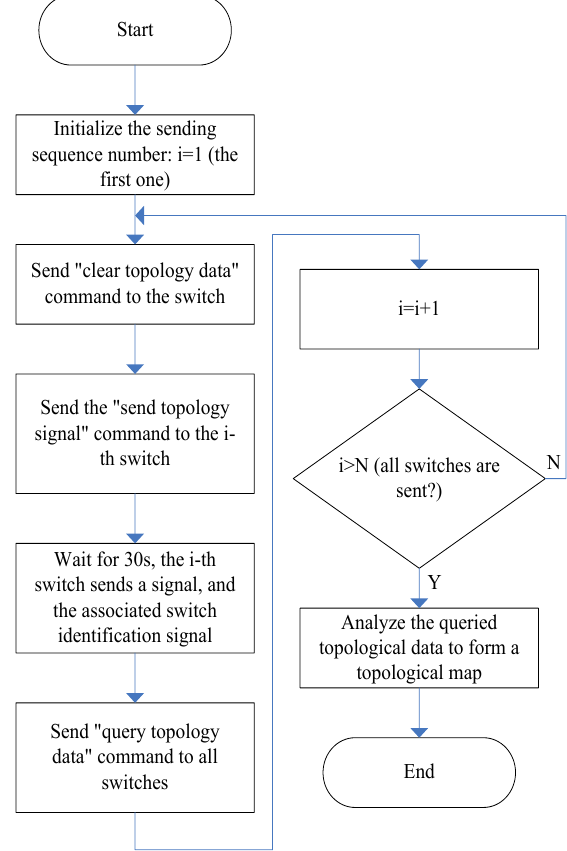
Figure 7. Topology identification process.